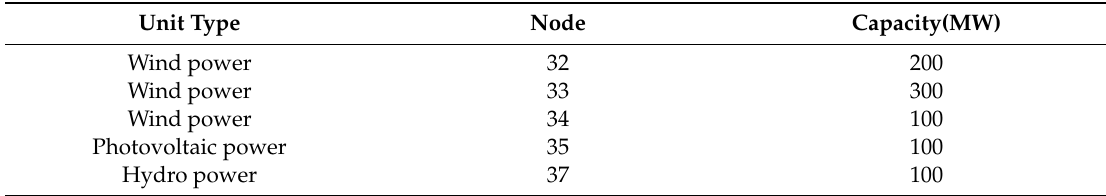
Figure 13. Zone figure of modified IEEE 39-node system. Table 6. System Renewable Power Configuration.